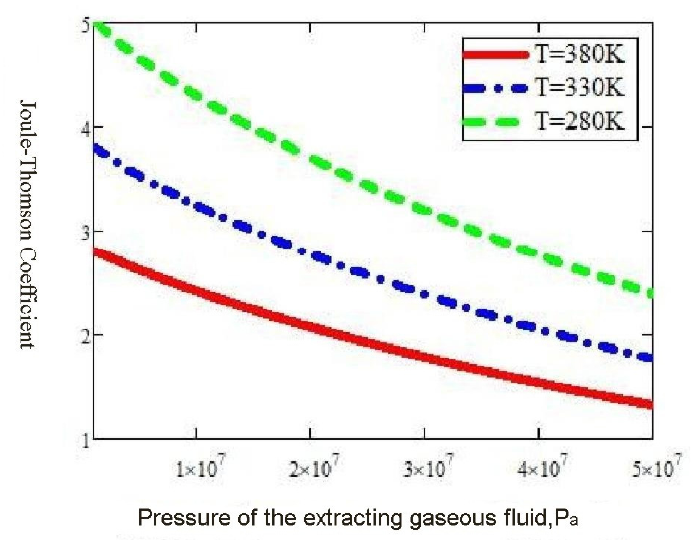
Figure 3. The dependence of D j ( P , T ).